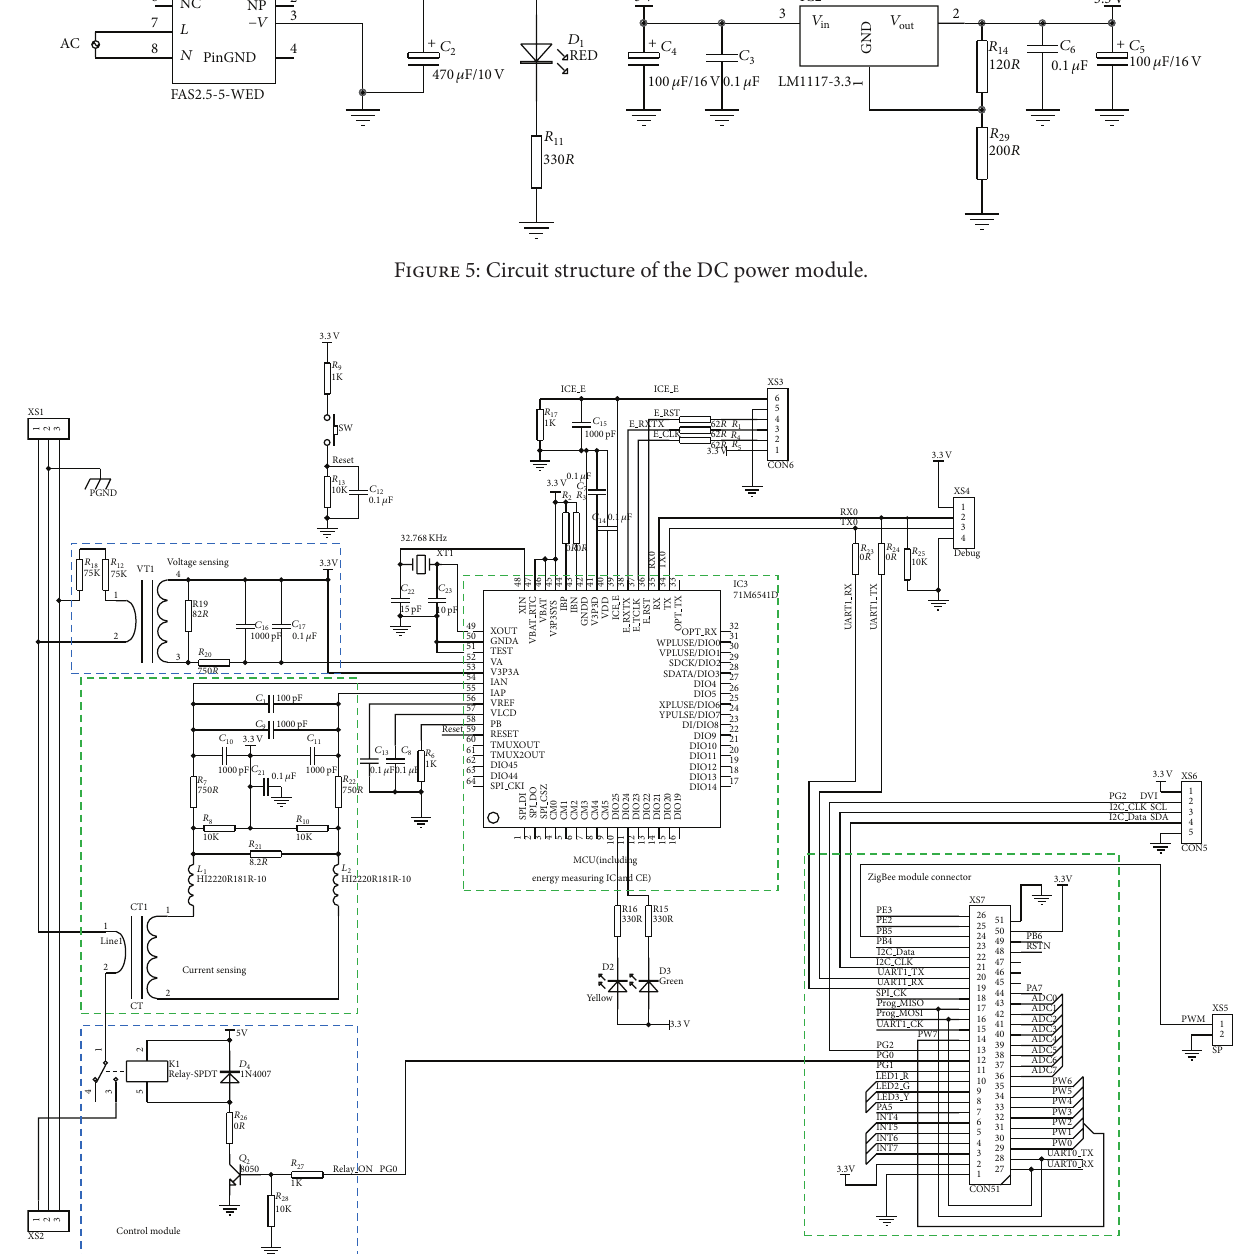
Figure 6: Circuit diagram of the sensor